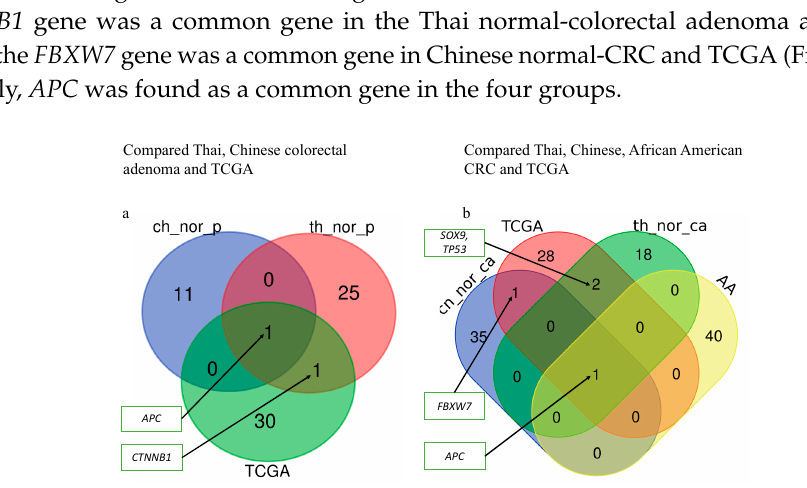
Figure 3. Comparison of high-frequency mutated genes. ( a ) The comparison of genes with somatic mutations from matched normal-colorectal adenoma in Thai CRC samples (th_nor_p), matched normal-colorectal adenoma in Chinese CRC samples (ch_nor_p) and matched normal-CRC in the TCGA sample; ( b ) the comparison of genes with somatic mutations in matched normal-CRC of Thai people (th_nor_ca), matched normal-CRC in Chinese people (ch_nor_ca), TCGA, and African American (AA) CRC sample.